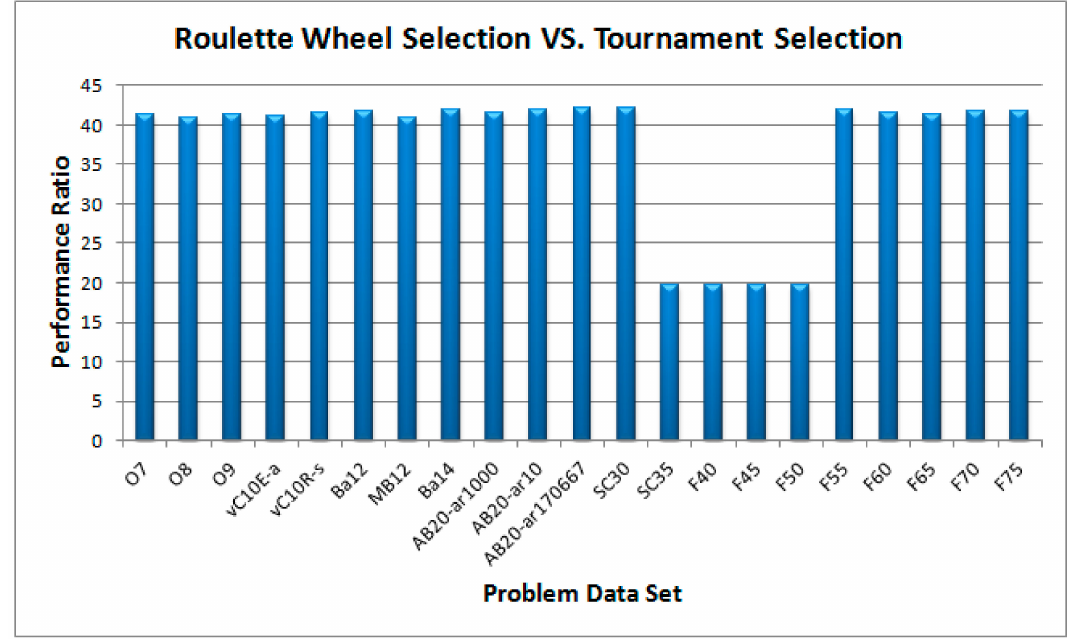
Figure 9. Performance ratio between SEL_RL and SEL_TN for selection